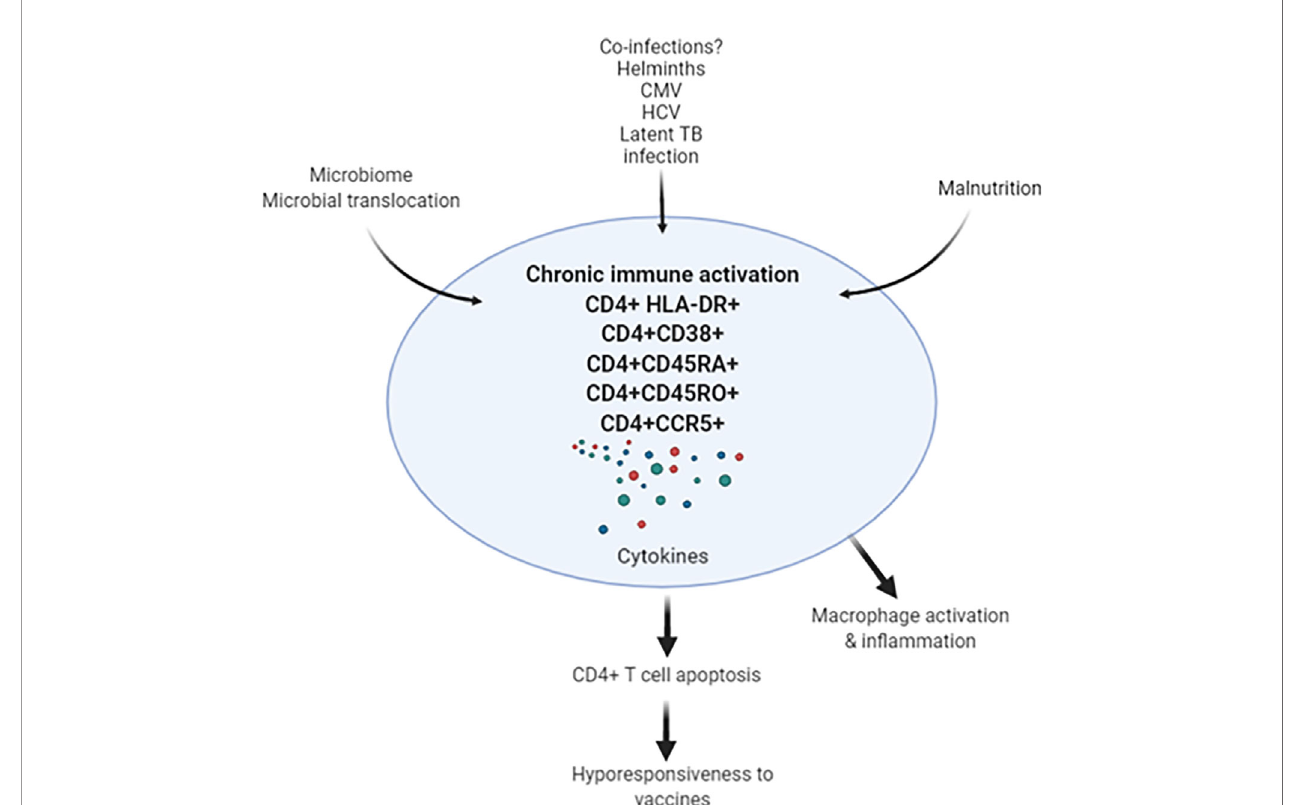
FIGURE 1 | Chronic immune activation in apparently health Africans may be related to leaky gut, co-infections (such as helminths, CMV, HCV and latent TB infection) results in activation-induced CD4 + T cell apoptosis. In turn, depletion of CD4 + T cells may result in decreased response to SARS-CoV-2 vaccine in the African population. CMV, cytomegalovirus; HCV, hepatitis C virus; TB,